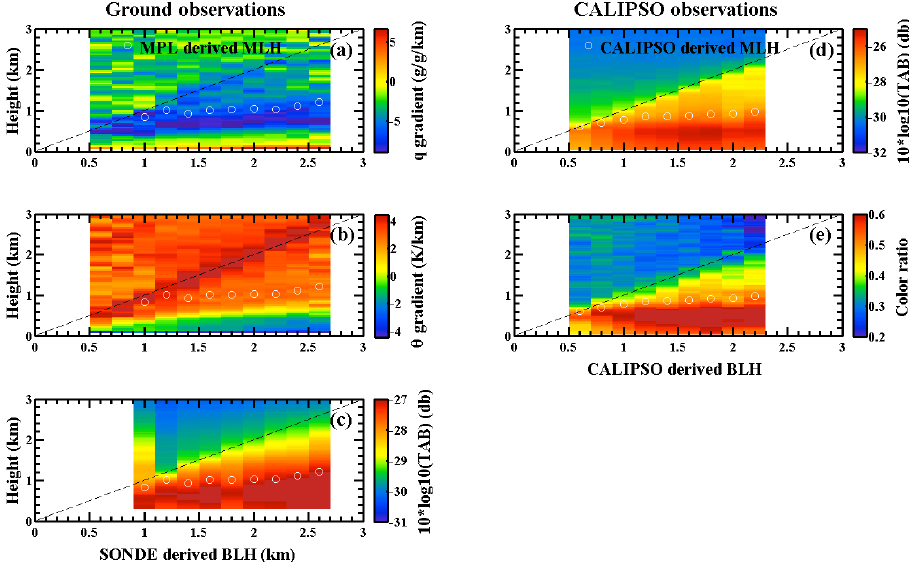
Figure 8. Left panel: Ground based observations at marine site of marine boundary layer decoupled structure in terms Fig. 8. Left panel: Ground-based observations at the marine site of marine boundary layer decoupled structure in terms of mixing ratio (a) , of mixing ratio (a) , potential temperature (b) and TAB (c) ; Right: The same but for satellite based observations near the potential temperature (b) and TAB (c) . Right: The same but for satellite-based observations near the marine site in terms of TAB (d) and marine site in terms of TAB (d) and Color ratio (1024nm/532nm) (e) . The white circles are the MPL derived MLH (a, color ratio (1024nm/532nm) (e) . The white circles are the MPL-derived MLH (a, b, c) or CALIPSO-derived MLH (d, e) . b, c) or CALIPOSO derived MLH (d, e).